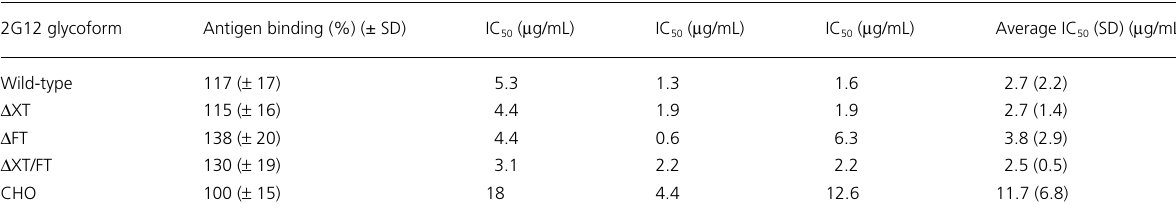
Table 2 Analysis of functional integrity of 2G12 glycoforms. Antigen-binding capacity was detected by a specificity enzyme-linked immunosorbent assay (ELISA) coated with purified human immunodeficiency virus (HIV) glycoprotein 160 (gp160). In vitro HIV-1 neutralization activity of 2G12 glycoforms was detected by a syncytium inhibition assay using AA-2 cells 2G12